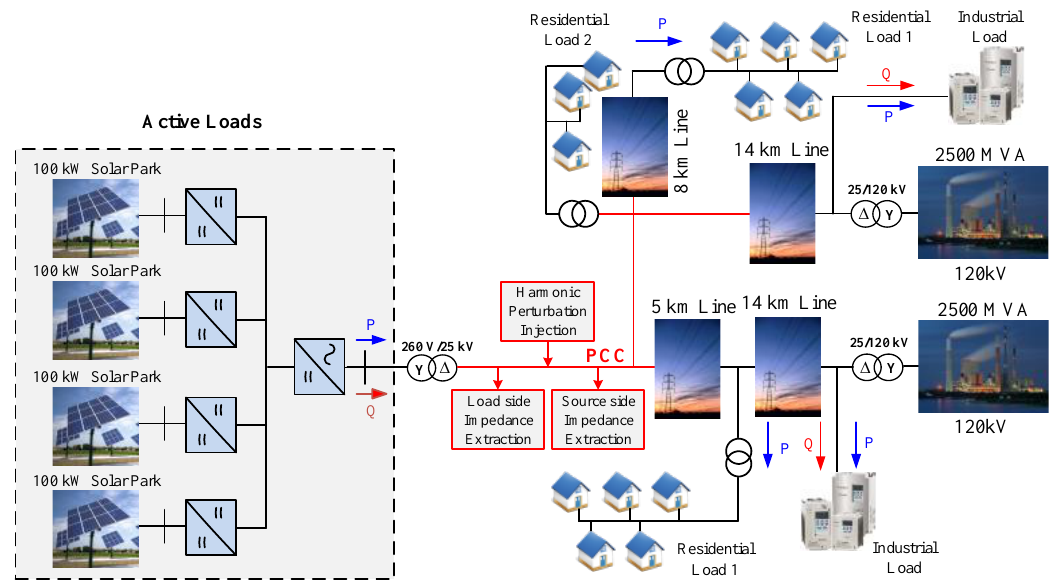
Figure 8. Simulink model of grid-connected active